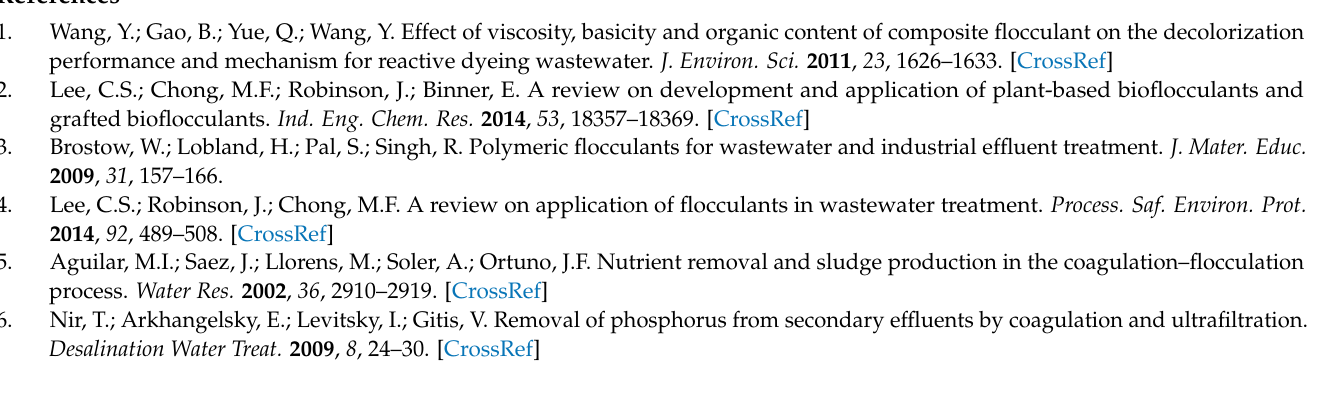
Figure S2: 1 H NMR spectra of lignin, PMETAC, and lignin–graft–PMETAC, Figure S3: Compari- son of total inorganic content of unmodified and modified lignin–METAC, Figure S4: (A) Weight loss as a function of temperature and (B) derivative weight loss as a function of temperature for unmodified lignin samples, Figure S5: (A) Weight loss as a function of temperature, and (B) derivative weight loss as a function of the temperature for lignin–METAC samples, Table S1: Trace elemental analysis of unmodified lignin determined via ICP MS